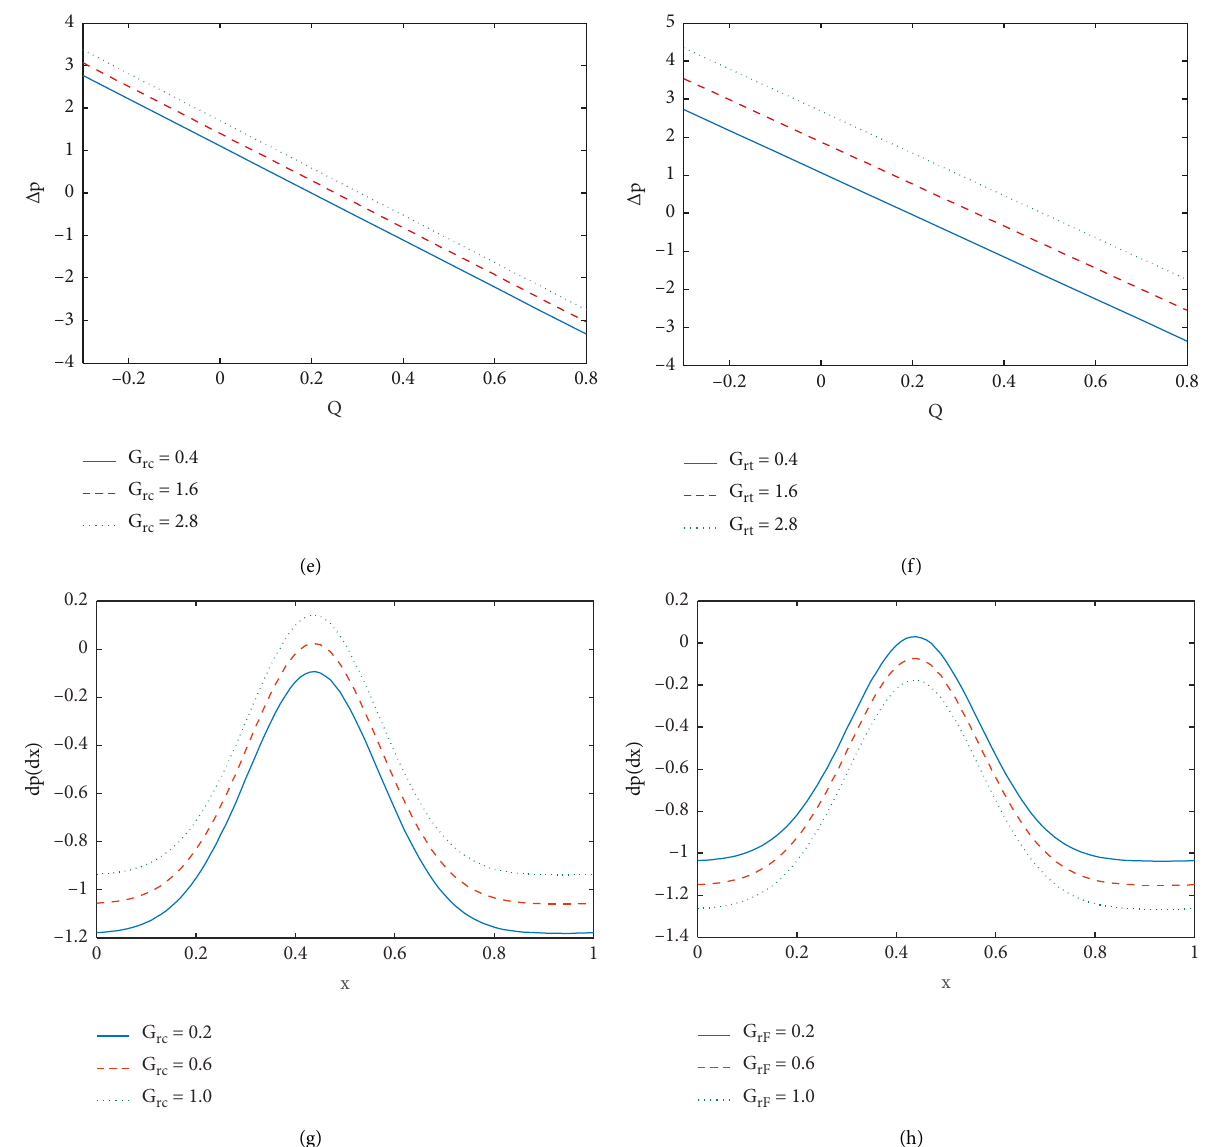
Figure 3: Influence of nanoparticle ( G